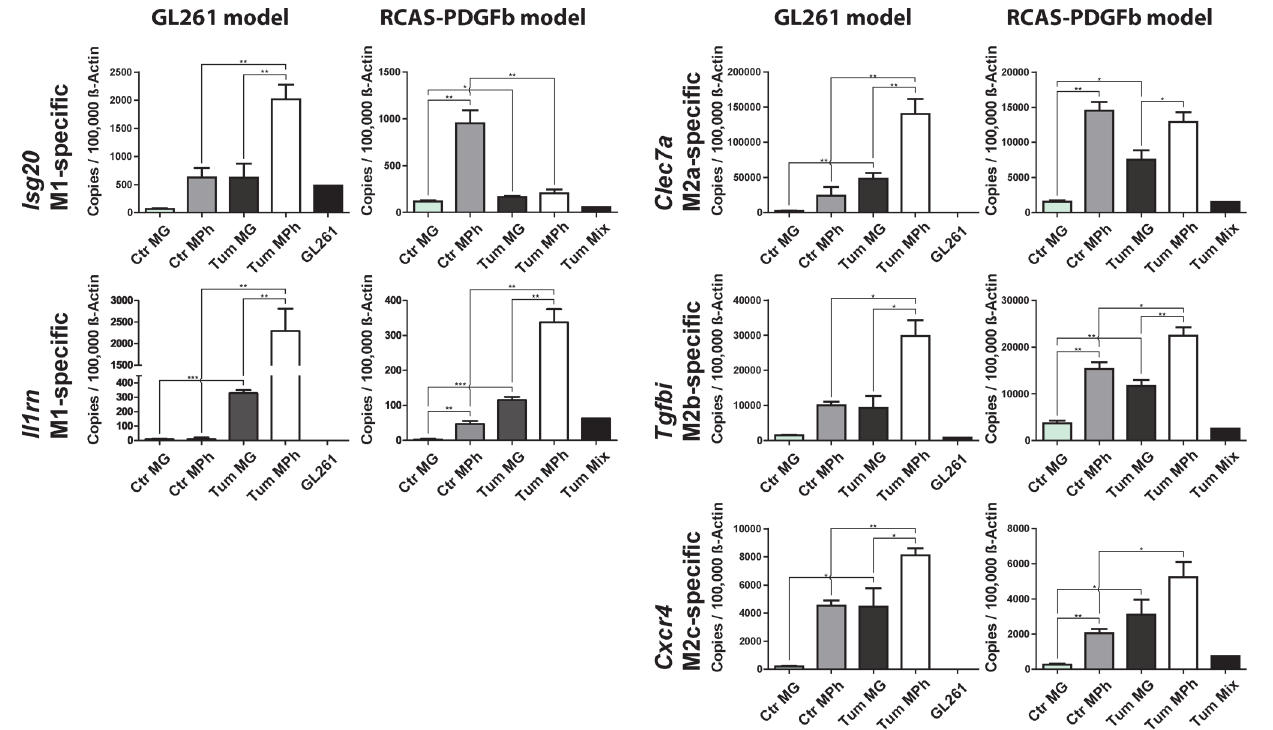
Fig 5. qPCR validation of selected M1 and M2a,b,c-specific genes in murine GAMs. We selected 5 genes that were upregulated in GAMs and specific for either M1 ( Il1rn and Isg20 ), M2a ( Clec7a ), M2b ( Tgfbi ), or M2c polarization ( Cxcr4 ) and investigated the expression of these using qRT-PCR. For this we isolated GAMs from GL261 and RCAS-PDGFb tumors using flow cytometry, in order to distinguish between resident microglia and invading macrophages/ monocytes and used microglia, and spleen-derived macrophages/monocytes from na ï ve mice as controls. CTR MG: na ï ve microglia, CTR Mph: na ï ve monocytes, Tum MG: glioma-associated microglia, Tum Mph: glioma-associated macrophages/monocytes, GL261: cultured GL261 cells, Tum Mix: cultured RCAS-PDGFb tumor cells. Bar graphs illustrate the absolute number of transcripts normalized to 100,000 transcripts of Actb (n = 4). Analysis was done by students t test. Error bars indicate the Standard Error of Mean (SEM). * , p < 0.05; ** , p < 0.01; *** , p < 0.001